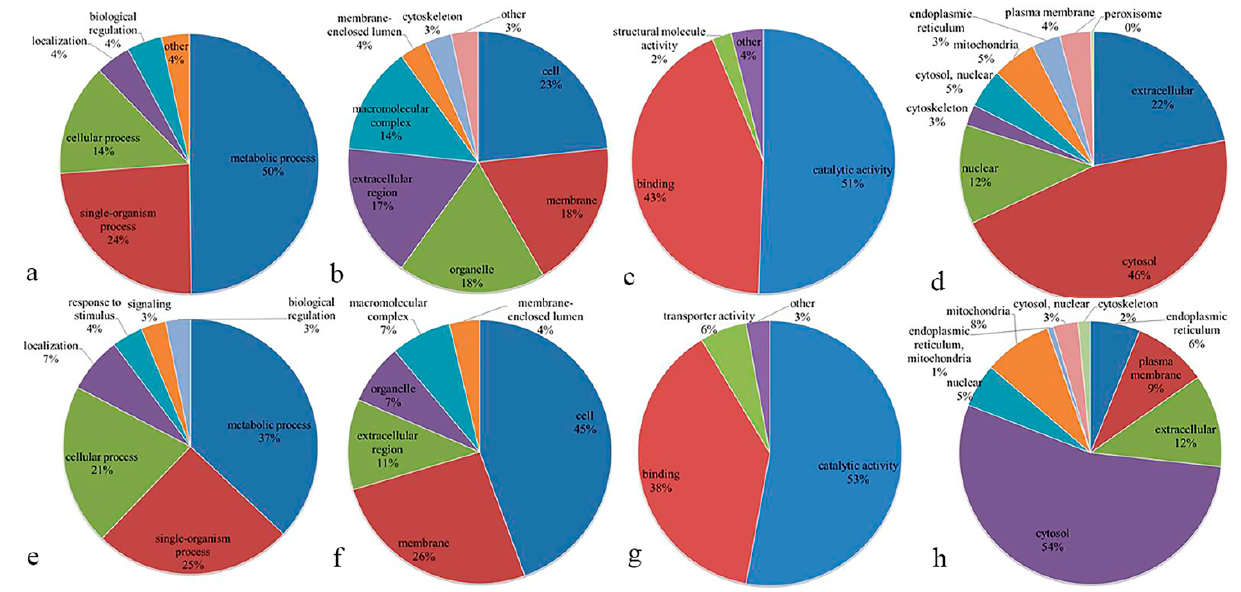
Figure 5. Pie charts indicating the Gene Ontology (GO) functional classification of the DEPs in IADA/COSMA group: ( a ) up-regulated DEPs categorized according to biological process; ( b ) up- regulated DEPs categorized according to cellular component; ( c ) up-regulated DEPs categorized ac- cording to molecular function; ( d ) subcellular localization of up-regulated DEPs; ( e ) down-regulated DEPs categorized according to biological process; ( f ) down-regulated DEPs categorized accord- ing to cellular component; ( g ) down-regulated DEPs categorized according to molecular function; ( h ) subcellular localization of down-regulated DEPs.